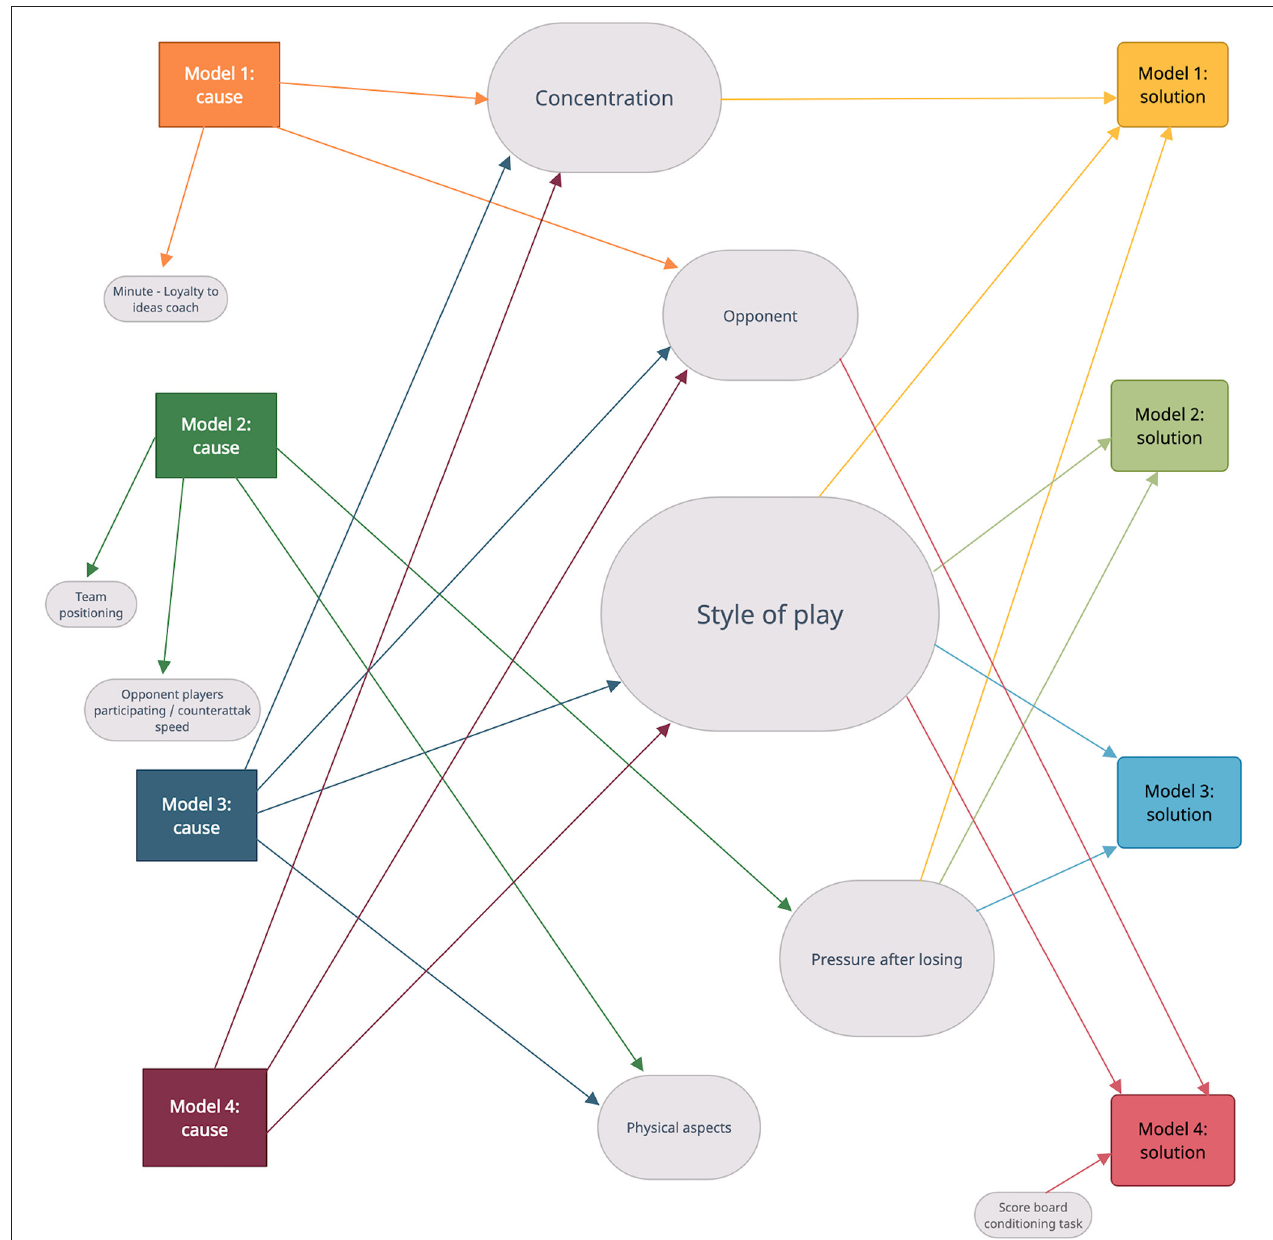
FIGURE 4 | Relationship between causes and solutions in the four predictive